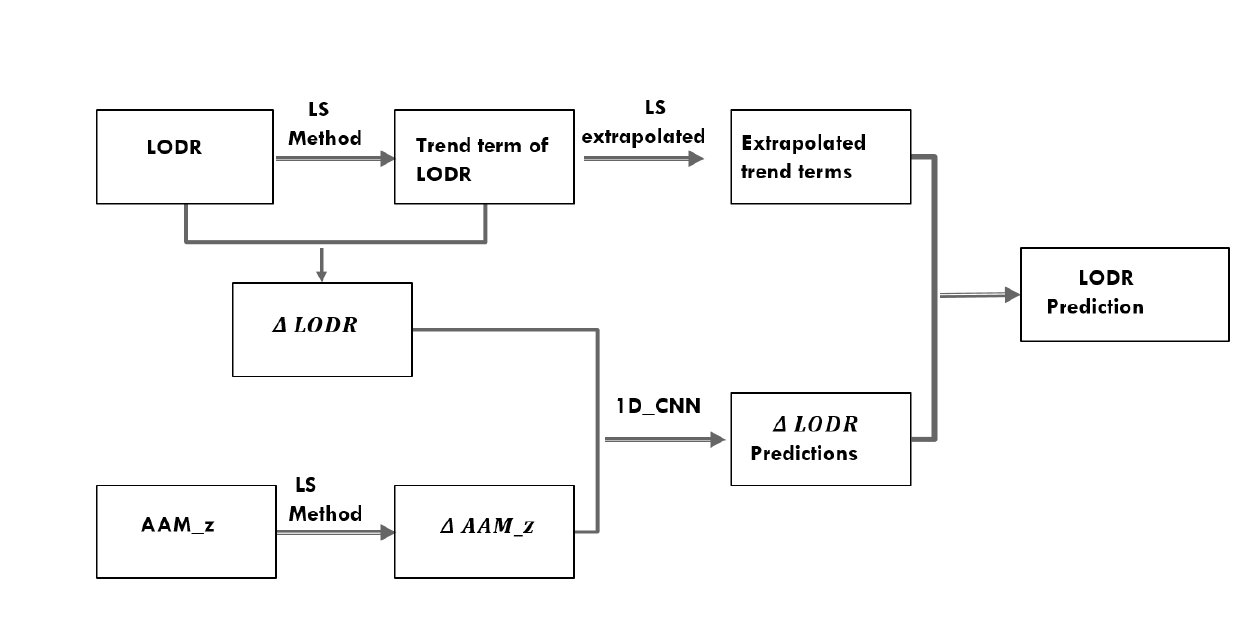
Figure 2. Flowchart of introducing the AAM to LODR predictions using 1D